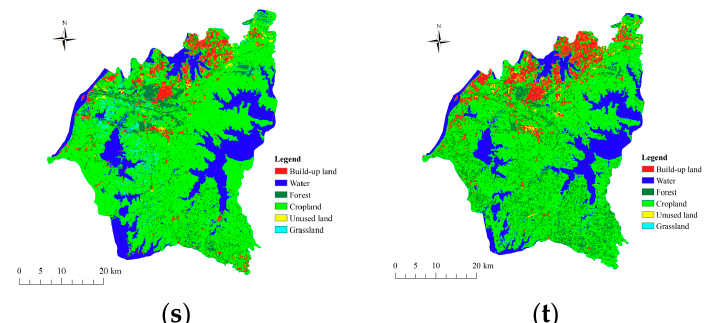
Figure 10. The LULC results of four representative districts at five typical time nodes: ( a – e ) are the LULC results of Jianghan in